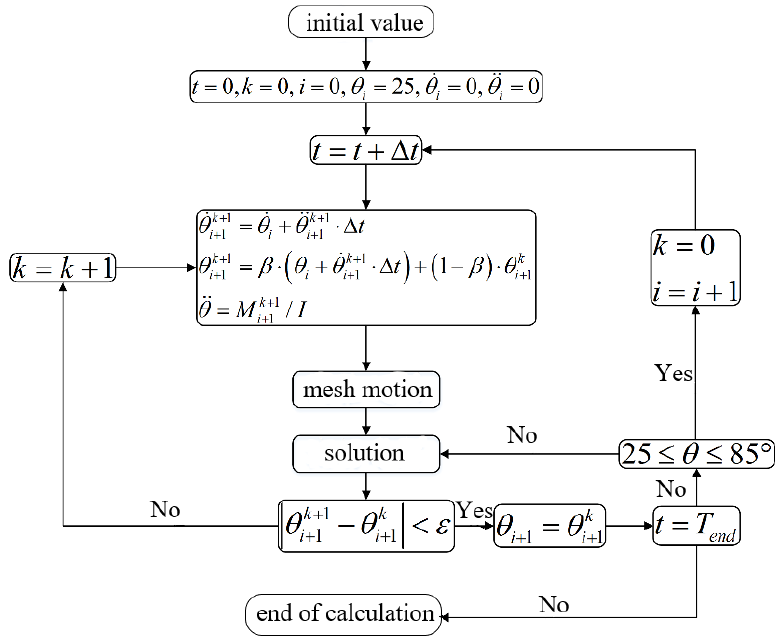
Figure 2. Calculation process of fluid flowing in mechanical heart valve.